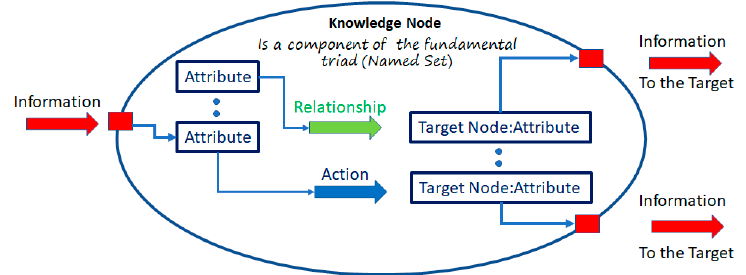
Figure 3. Knowledge node represents an entity that receives information and processes it based on its internal knowledge.